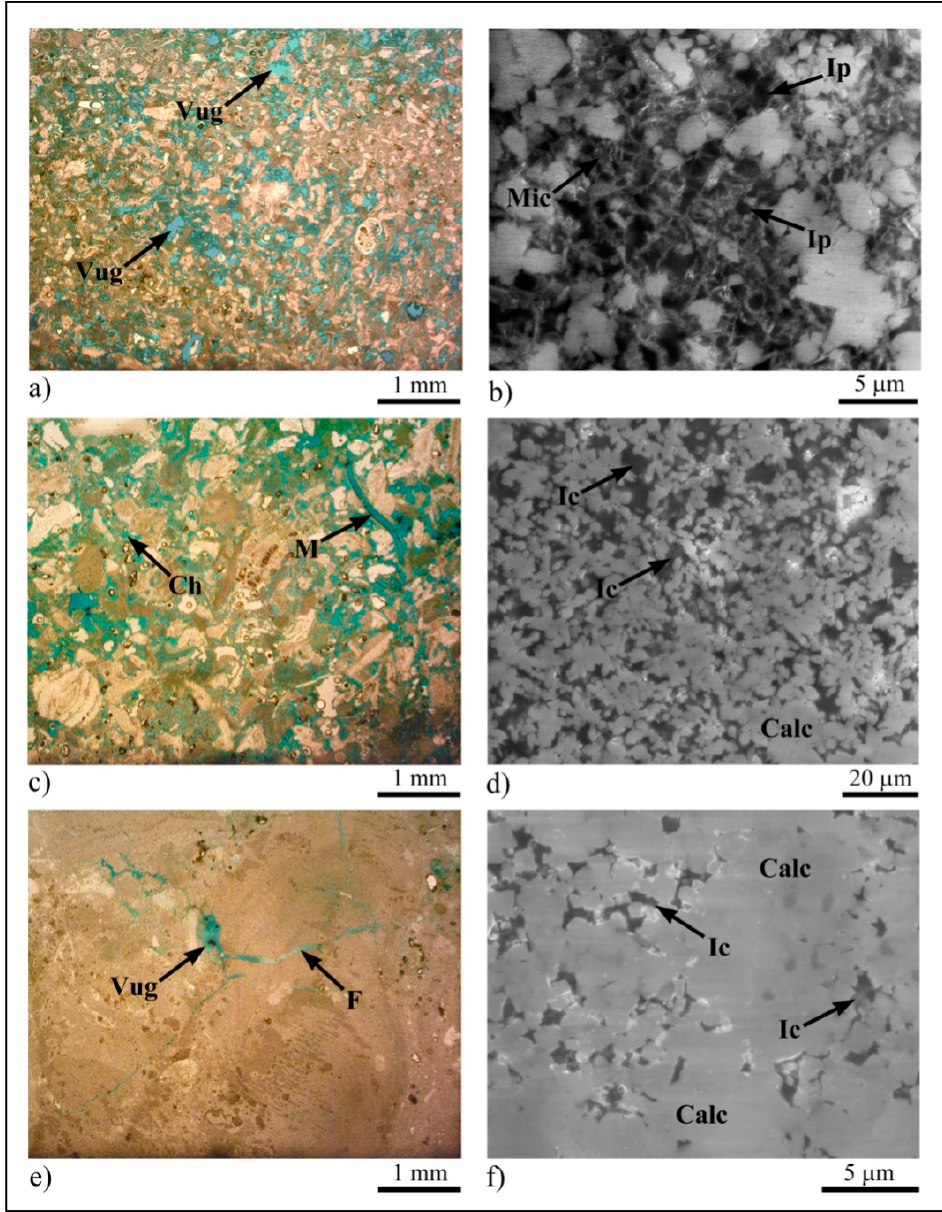
Figure 8. Porosity of Calcari di Cagliari Auct. ( a ) Vug porosity (Vug) in Pietra Cantone, OM plane polarized light; ( b ) interparticle porosity (lp) in micrite mud (Mic) of Pietra Cantone, SEM backscattered-electron (BSE) image, EHT = 20 kV, WD = 10 mm; ( c ) moldic (M) and channel (Ch) porosities in Tramezzario, OM plane polarized light; ( d ) intercrystal (lc) porosity in Tramezzario calcite (Calc) cement, SEM BSE image, EHT = 20 kV, WD = 10 mm; ( e ) Vug and fracture (F) porosities in Pietra Forte, OM plane polarized light; ( f ) intercrystal (lc) porosity in Pietra Forte sparry calcite (Calc) cement, SEM BSE image, EHT = 20 kV, WD = 10 mm.